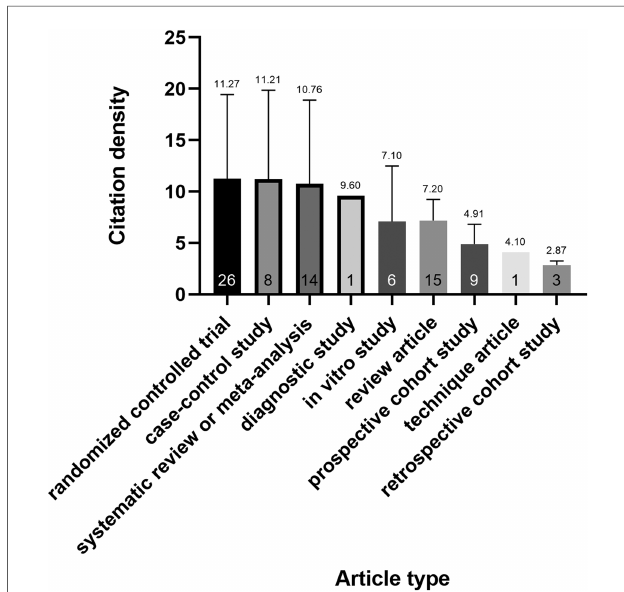
FIGURE 4 Mean citation density based on the article type. Note: The number at the bottom of the column represents the number of articles. there was no signi fi cant difference between article